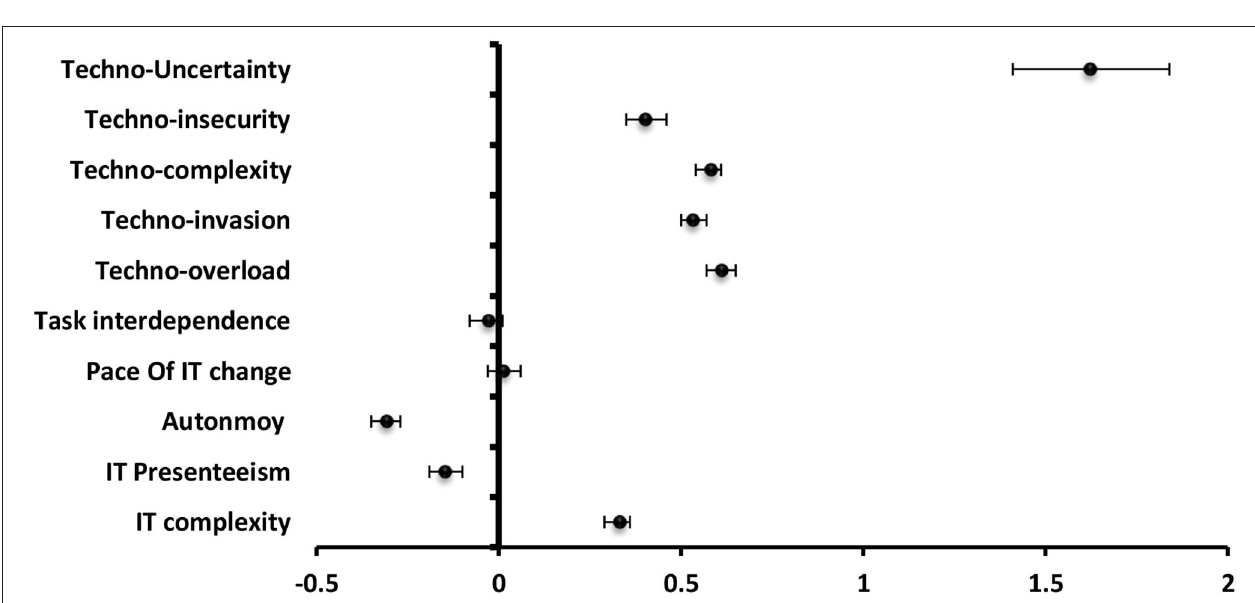
- Among the students, total technostress scores significantly positive predictor to cortisol level ( β = 6.64), strain ( β = 1.25), and burnout ( Figure 10 ). - Technology characteristics were significantly positive predictor to technostress among staff members and students ( β = 0.39 and β = 0.17), respectively, while job characteristics were significantly negative technostress predictors ( β = − 0.23 and β = − 0.12,) respectively ( Figure 11